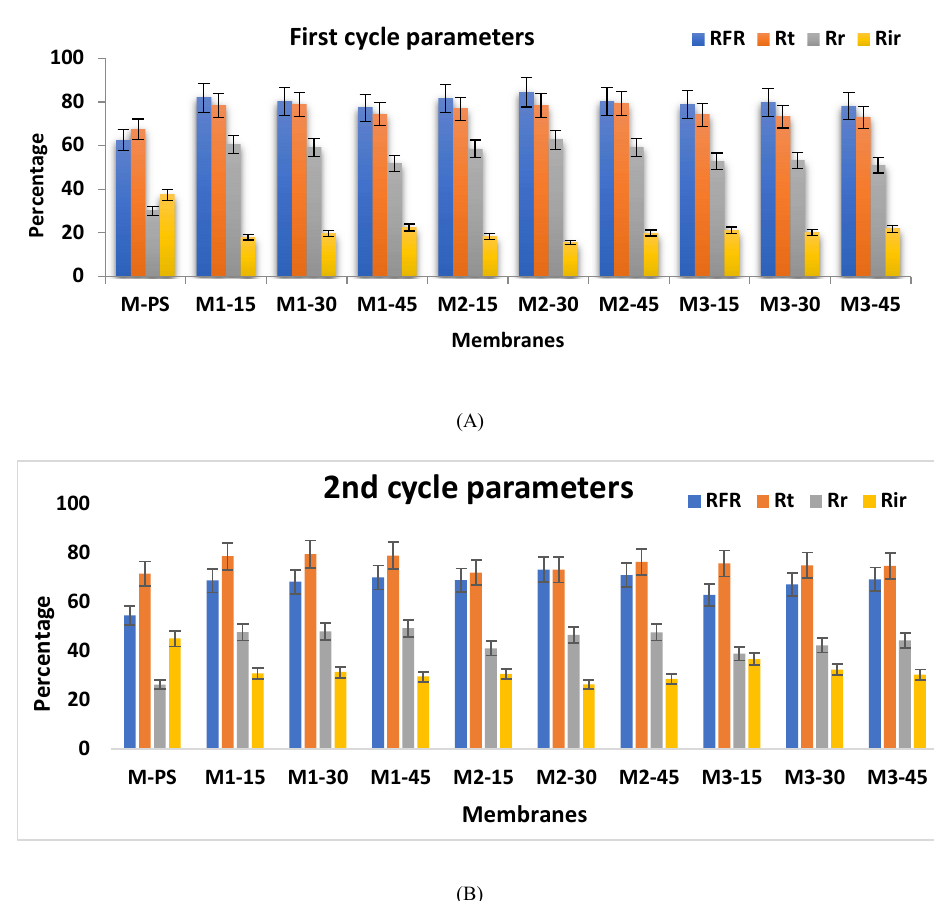
Figure 13. ( A , B ): Fouling parameters for all fabricated membranes, which included flux recovery (FFR), the membrane total resistance rate (Rt), the reversible resistance (Rr) and the irreversible resistance (Rir) rates ( n = 3).